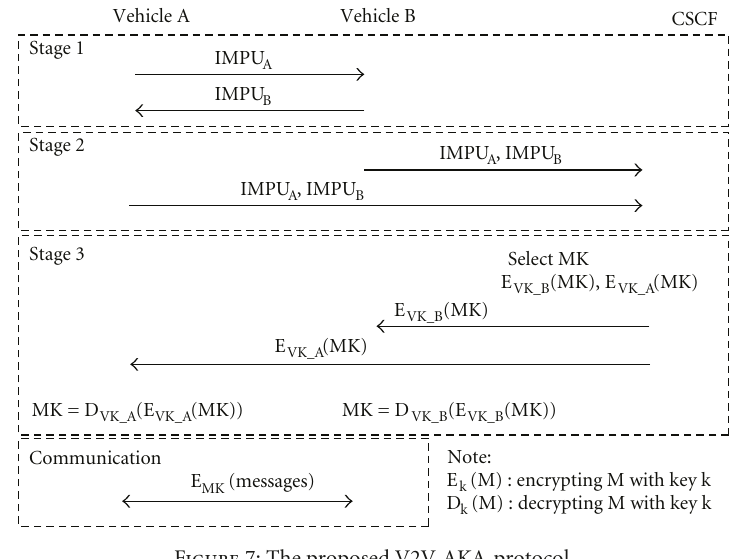
Figure 7: The proposed